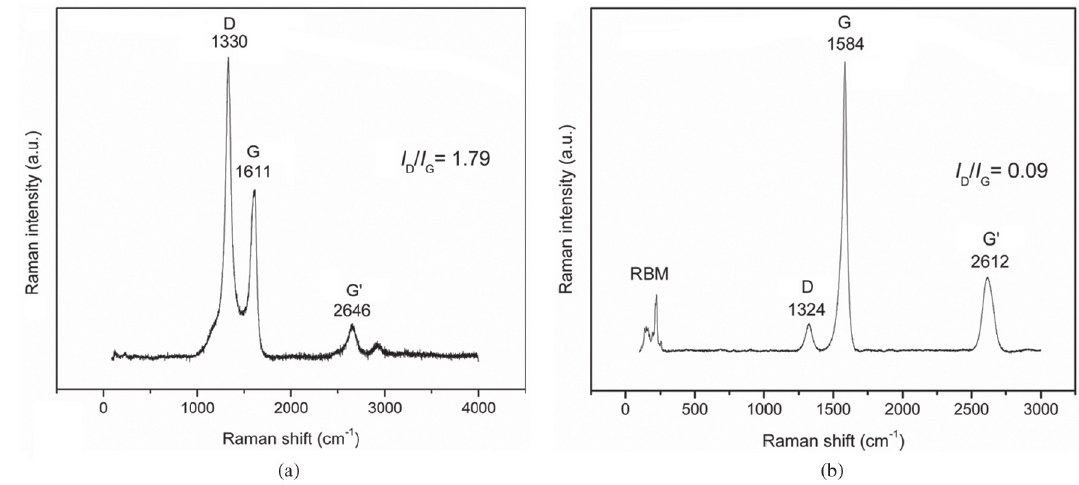
Figure 2. Raman spectra of adsorbents: (a) MWCNT; (b) SWCNT.